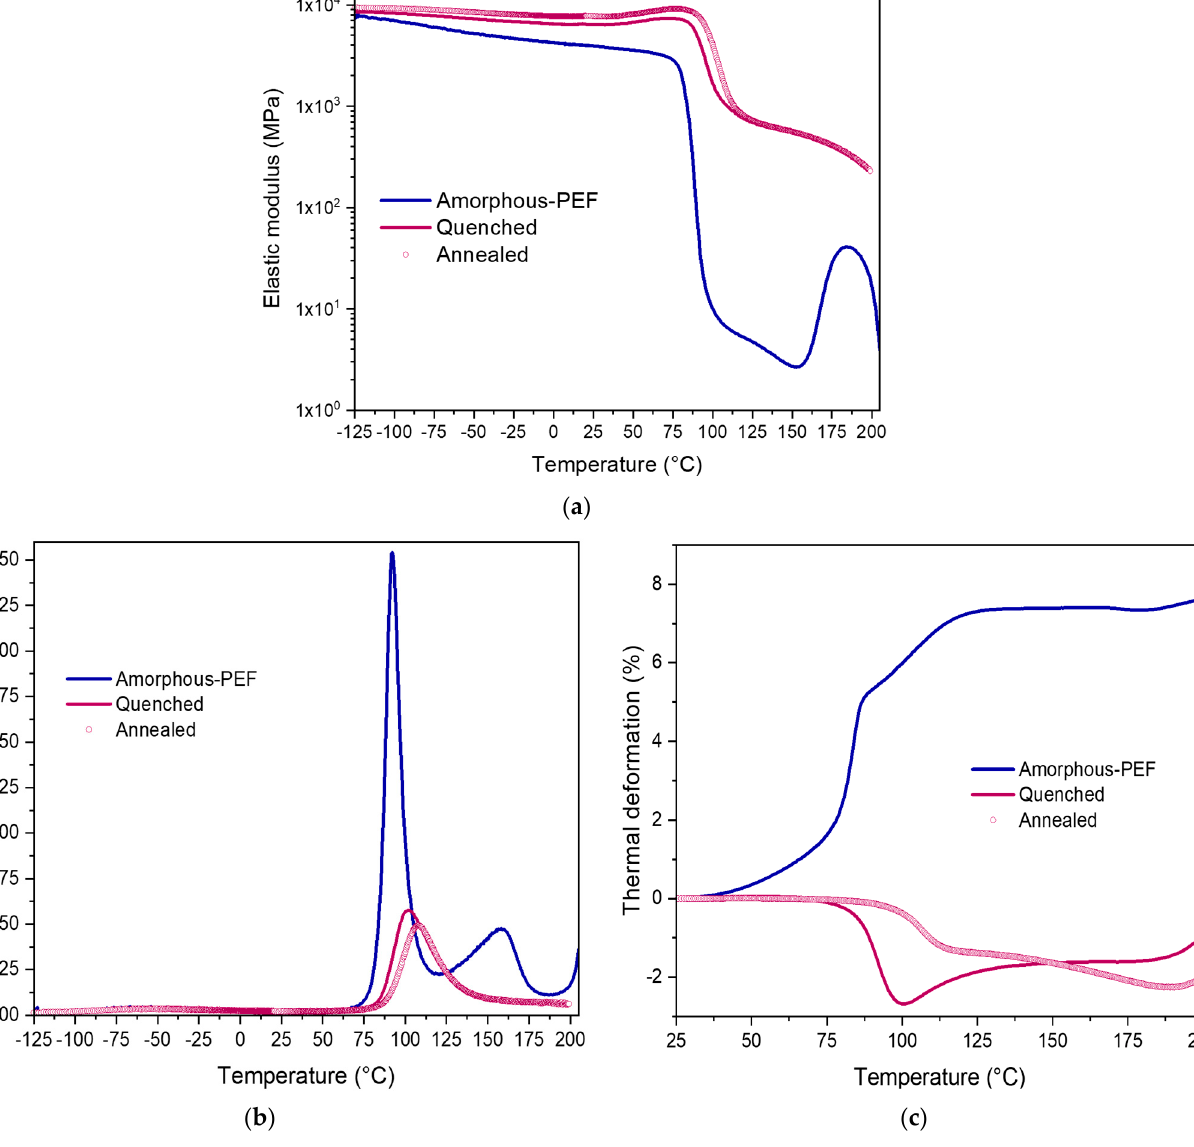
Figure 7. DMTA run of amorphous and biaxially stretched PEF carried out at 1° C/min and 1 Hz, depicting the evolution of ( a ) the elastic modulus ( E’ ), ( b ) Tan δ for temperatures ranging from - 125 °C to 210 °C and ( c ) the thermal deformation for temperatures varying from 25 °C to 200 °C.